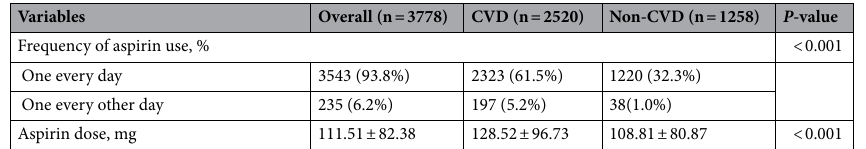
Table 2 shows the results of multivariable logistic regression analyses for the association between aspirin and different statin use and total CVD. After controlling for underlying cofounders, the odds ratios (ORs) with 95% confidence intervals (CIs) for CVD were 0.43 (0.33, 0.57), 0.69 (0.42, 1.13), 0.44 (0.31, 0.62), 0.34 (0.23, 0.50) and 0.64 (0.49, 0.84) for aspirin and different statin combinations (atorvastatin, lovastatin, pravastatin, rosuvastatin and simvastatin).